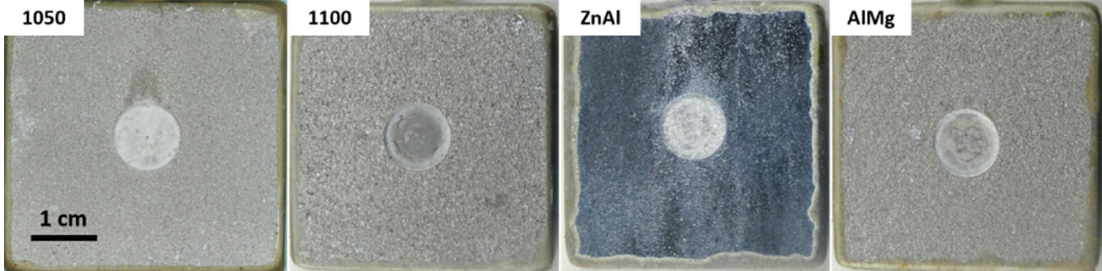
Figure 6. Images of TS samples after 50 days exposure to laboratory tests.